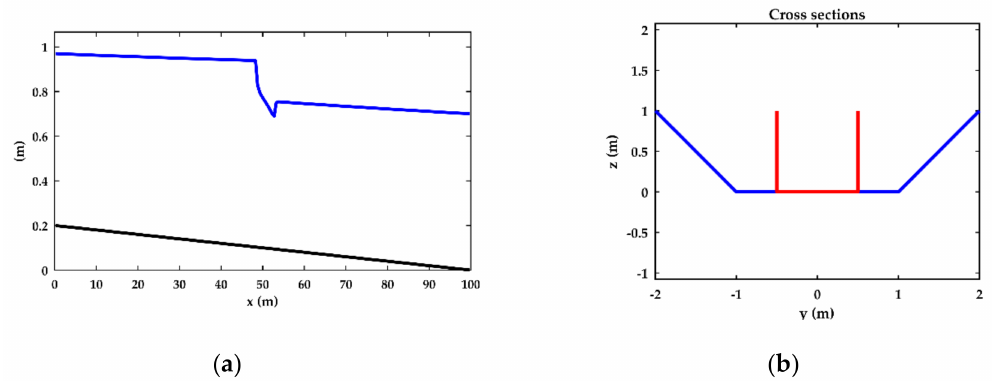
Figure 10. Hydraulic solution ( a ) and cross-section change ( b ) for test